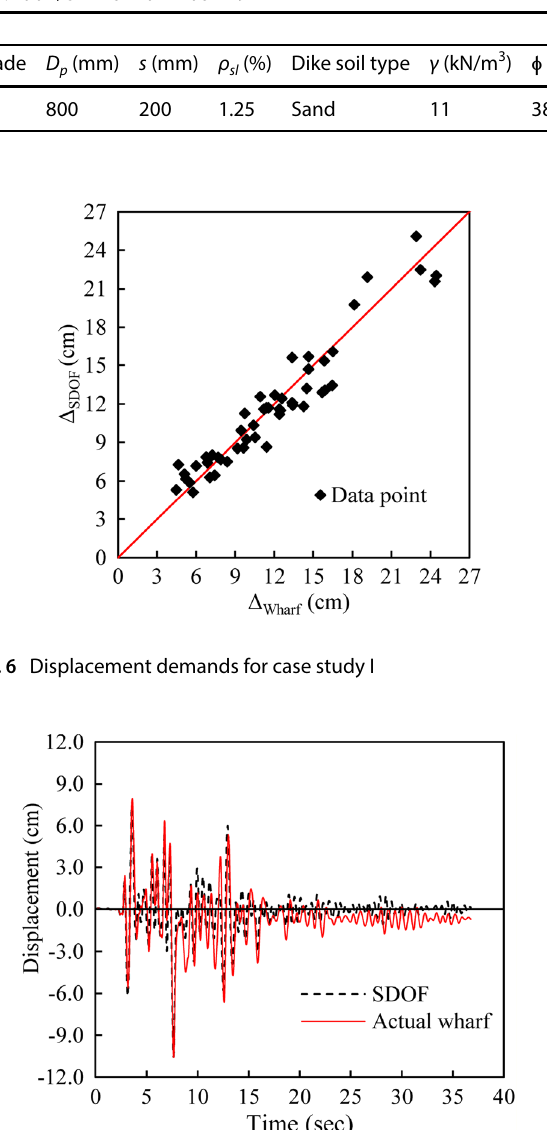
Fig. 7 Displacement time histories of SDOF system and actual wharf under a certain ground motion for case study